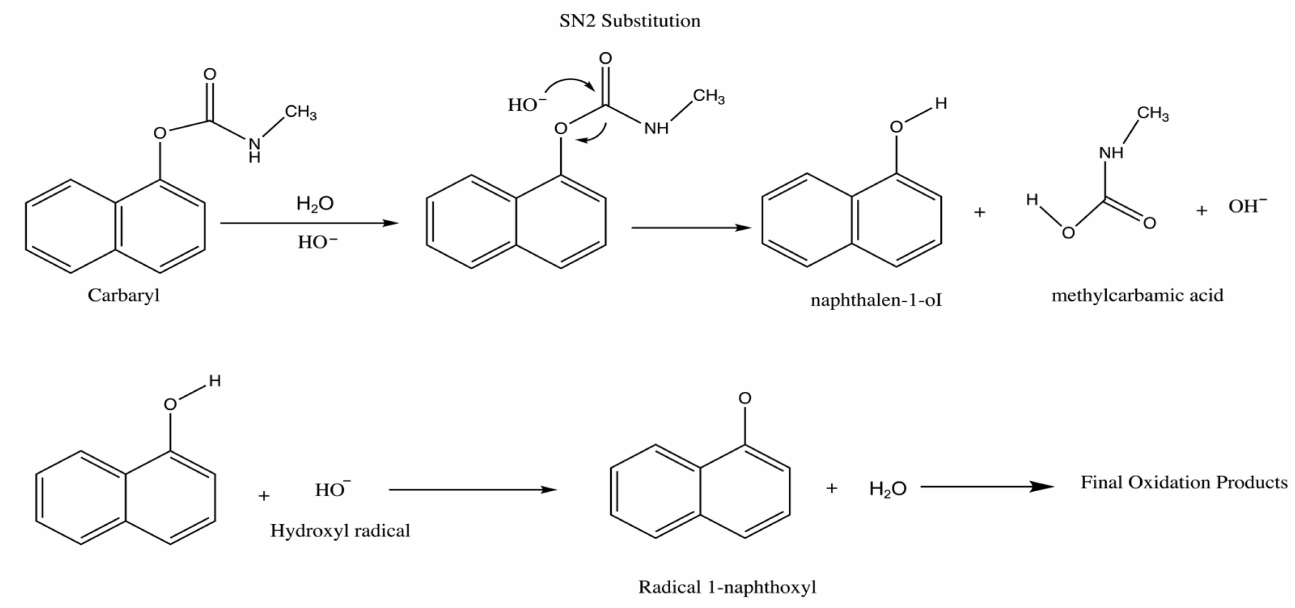
Figure 1. Scheme of the hydrolysis of